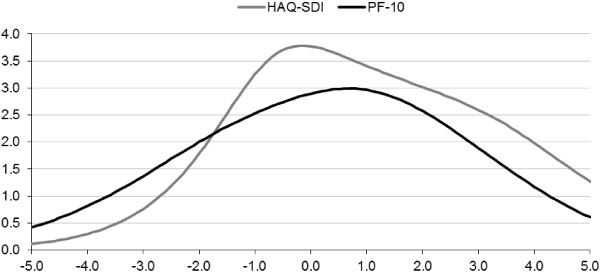
Test information function curve (partial credit model) for the HAQ-SDI and PF-10 in relation to theta. The test information function is the sum of all separate item information functions. Higher positive theta scores indicate worse physical functioning.